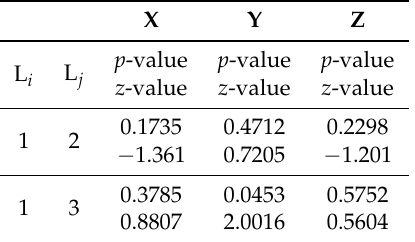
Table 9. Stochastic values for K Q in the free decay pendulum